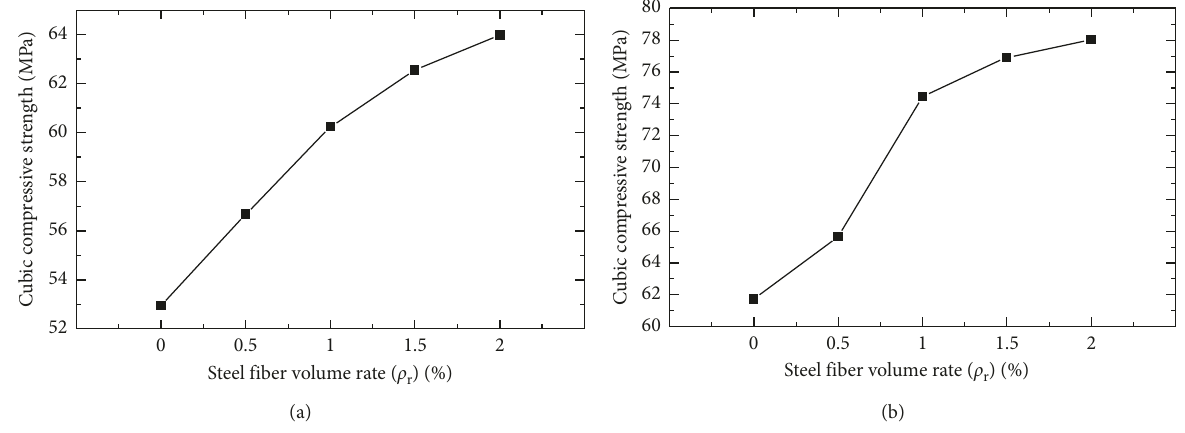
Figure 8: Relationship between compressive strength and steel fiber content. (a) CF50; (b) CF60.